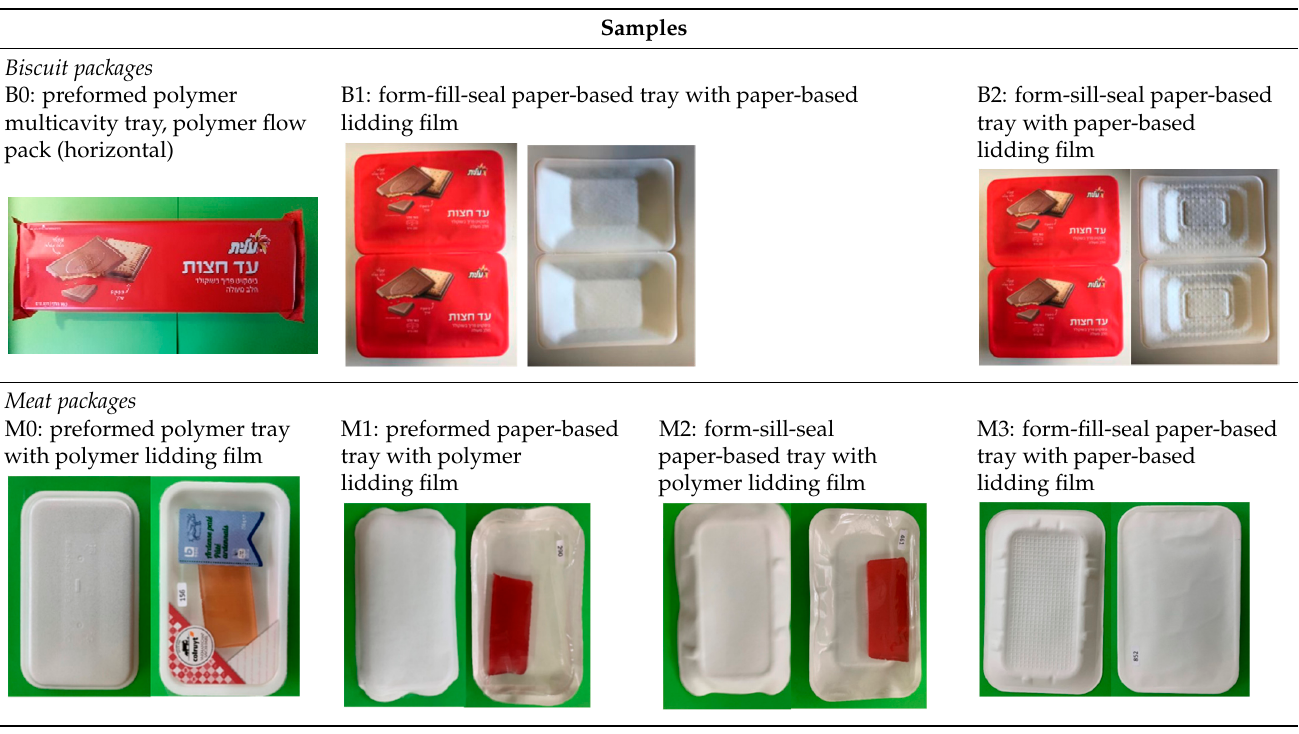
Table 1. Biscuit and meat packages.